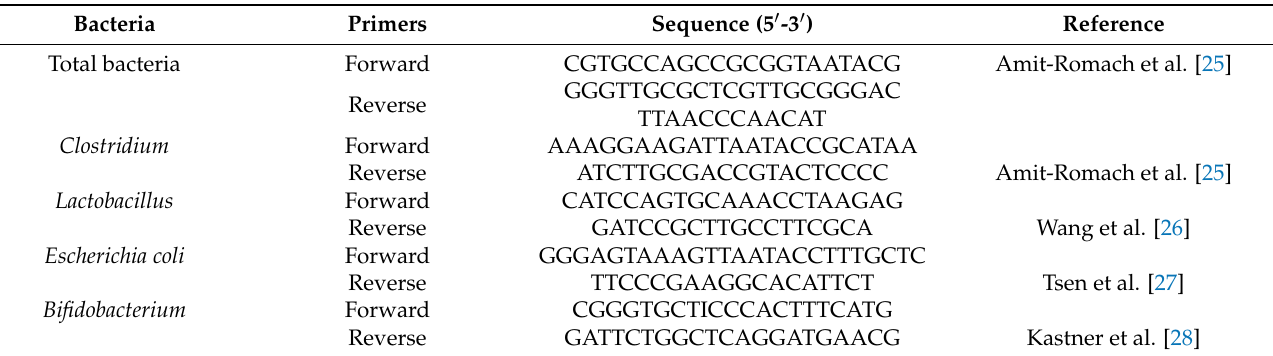
Table 3. Primer sets used for bacteria abundance